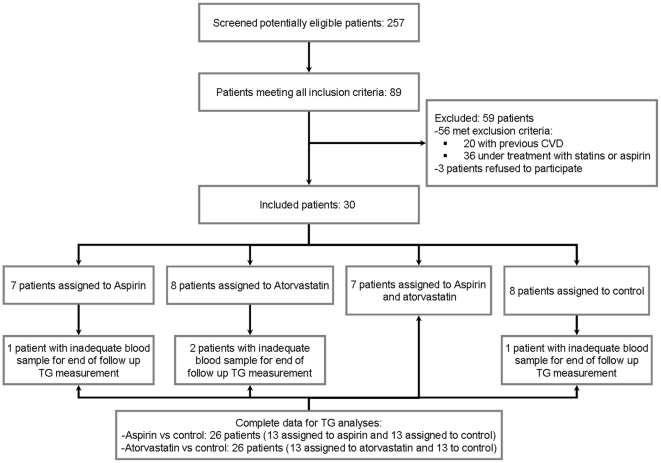
Study flowchart.